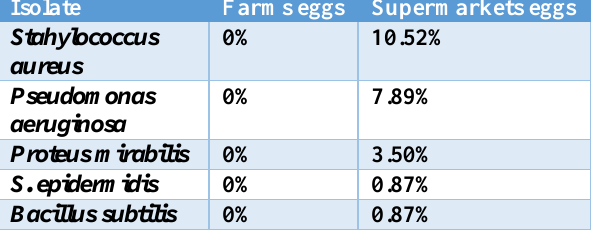
Table, 1: the percentages of bacterial isolates in eggs samples